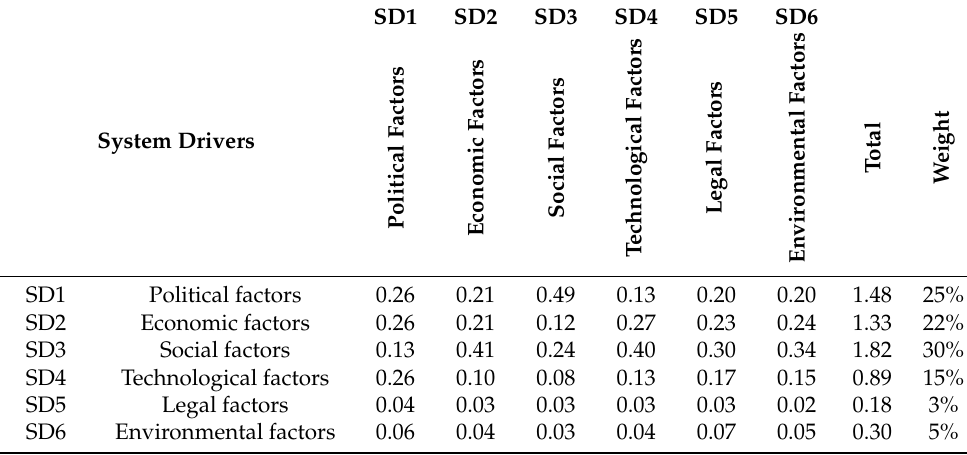
Table A2. System Drivers (SD) for Remote community generation.